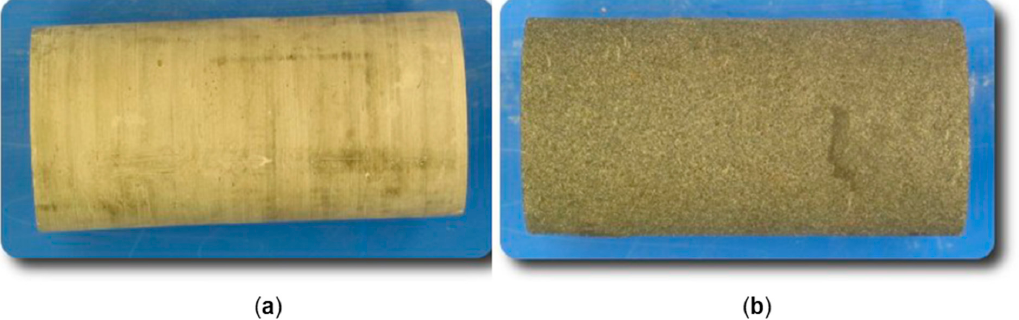
Figure 4. ( a ) Shale specimen and ( b ) stone specimen.